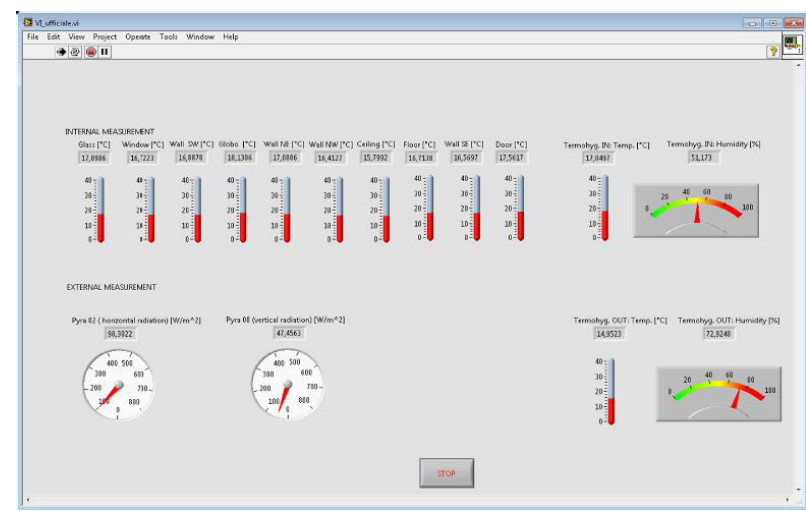
Figure 8. Front panel of the developed LABVIEW tool.